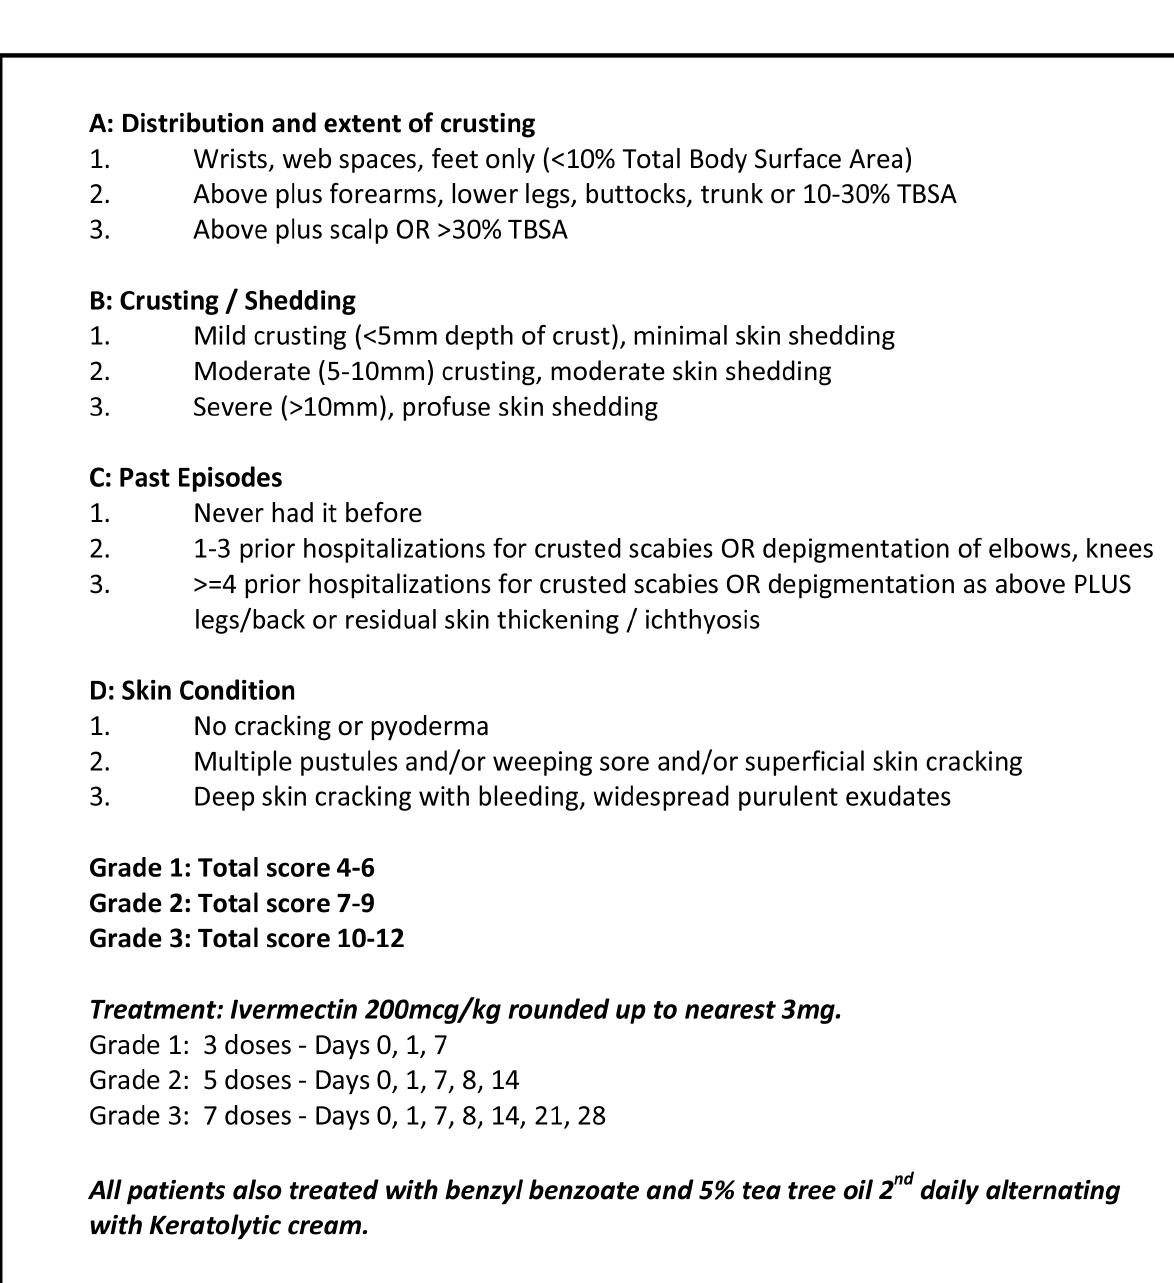
Figure 1. Severity grading scale for crusted scabies.